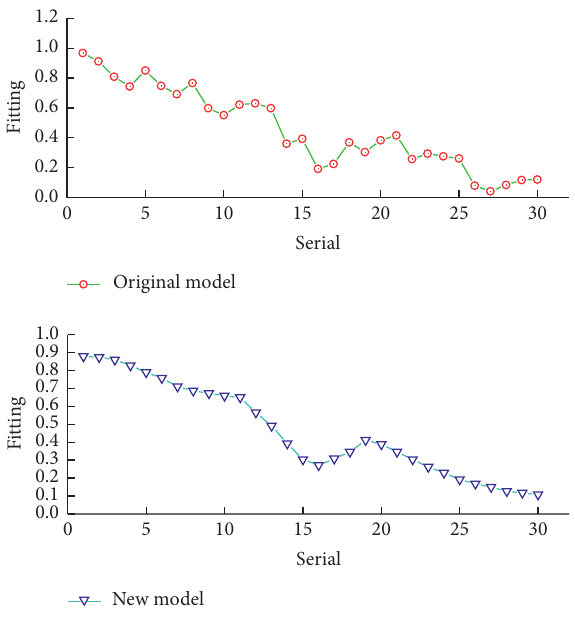
New Figure 6: Comparison